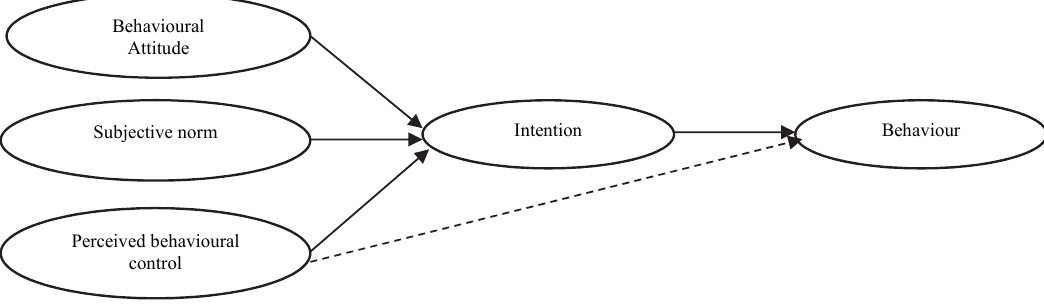
Fig. 1. Theory of planned behaviour (adapted from Ajzen,